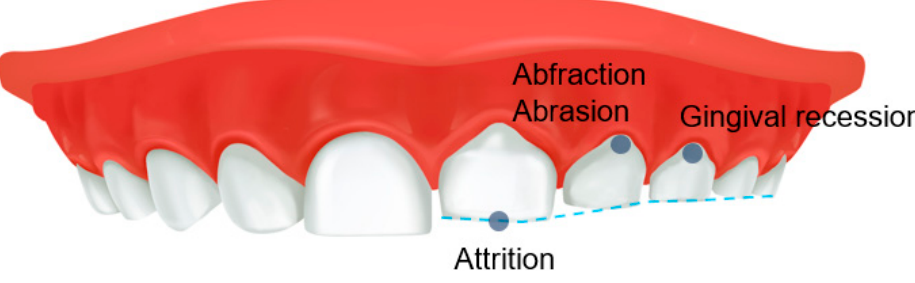
Figure 3. Adverse effects of sleep bruxism on teeth in children.